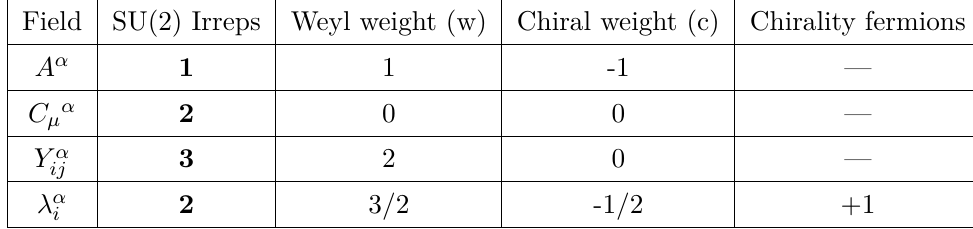
Table 6 . N = 2 superconformal Yang-Mills